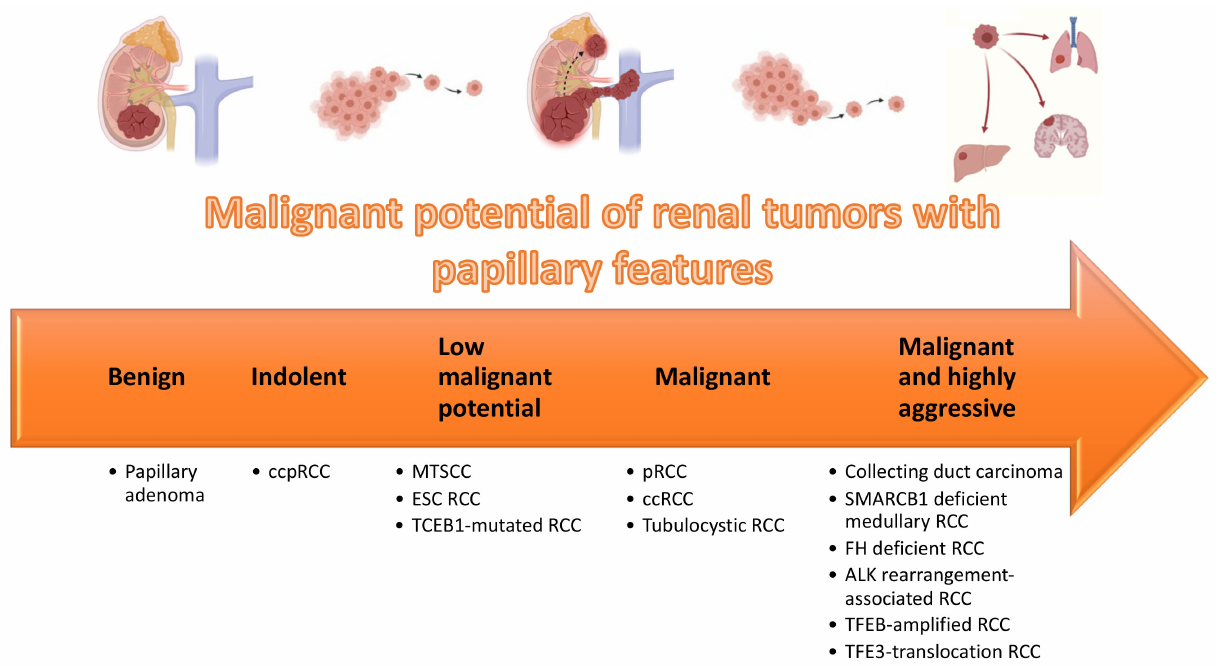
Figure 11. Organization of renal tumors with papillary features according to malignant